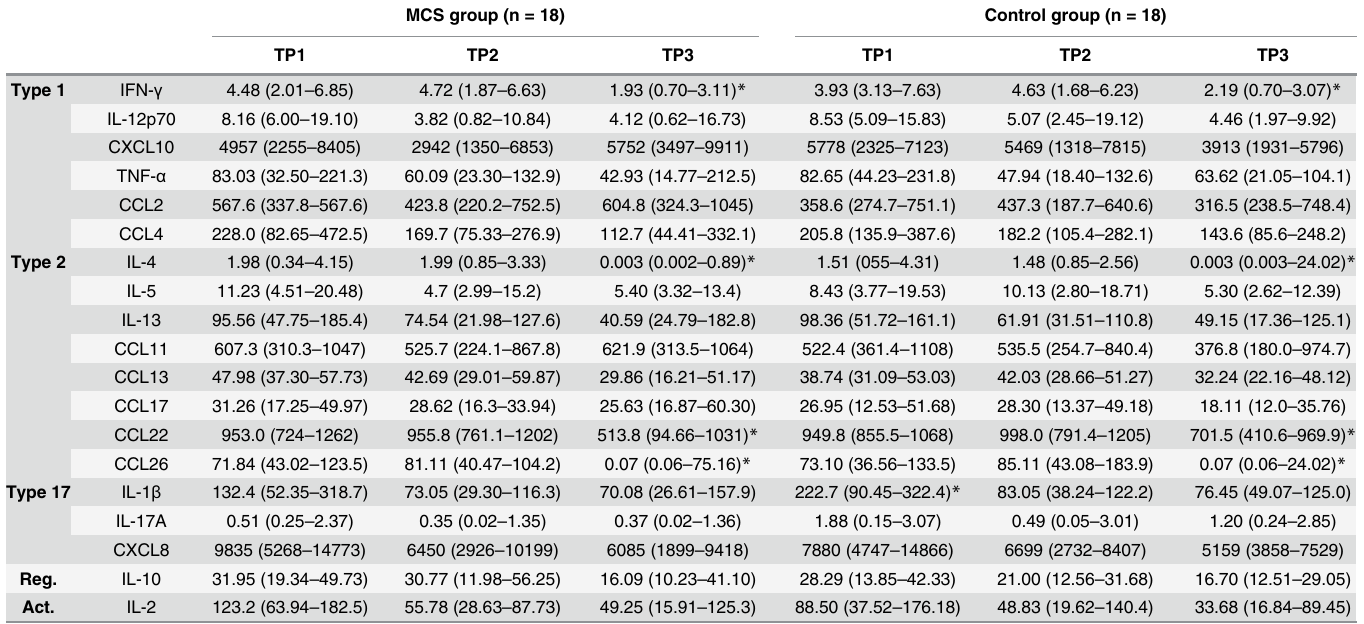
Table 2. Quantified levels of immune mediators in epithelial lining fluid of upper airways. Median level with interquartile range of each mediator (in pg analyte/mg total protein) measured in the upper airway epithelial lining fluid from the MCS group and from the control group at the three time points (TP); TP1 at zero hours, TP2 at the end of exposure and TP3 4 hours post exposure session. Asterisks refer to significant differences (P (cid:1) 0.05) in analyte concentra- tion between TP1, TP2 and TP3 within either the MCS or the control group identified using an Kruskal-Wallis test and Dunn's (1964) procedure with a Bonfer- roni correction for multiple comparisons as post-hoc analysis. CCL = Chemokine (C-C motif) ligand, IL = interleukin, IFN- γ = interferon- γ ; TNF- α = tumor necrosis factor- α . The immunological mediators are sorted according to whether they are mainly represented in type-1 responses, type-2 responses, type-17 responses or involved in immune regulation (Reg) or activation